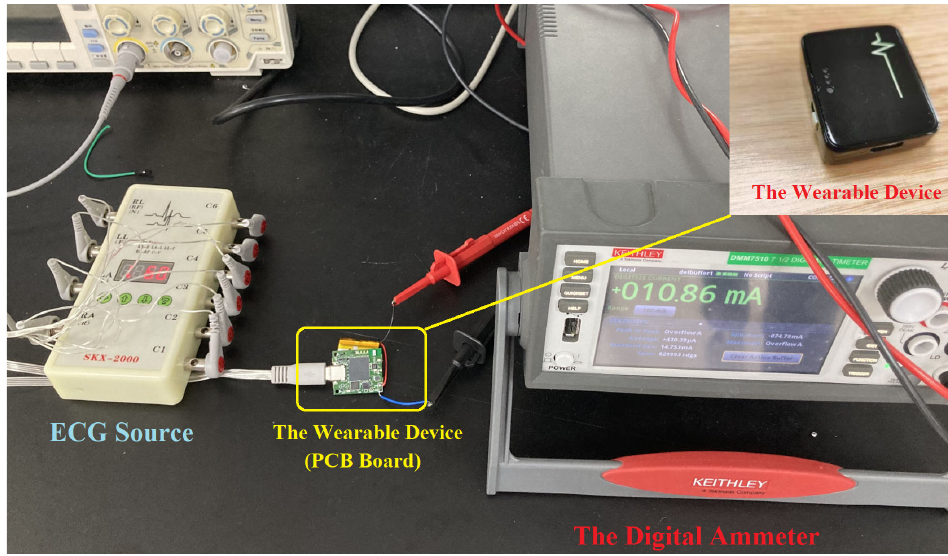
Figure 10. A diagram of measuring current.